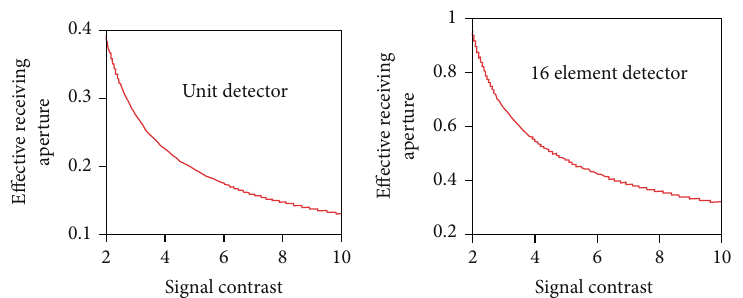
Figure 3: Contrast and e ff ective aperture for single-pixel detector and 16 detectors.